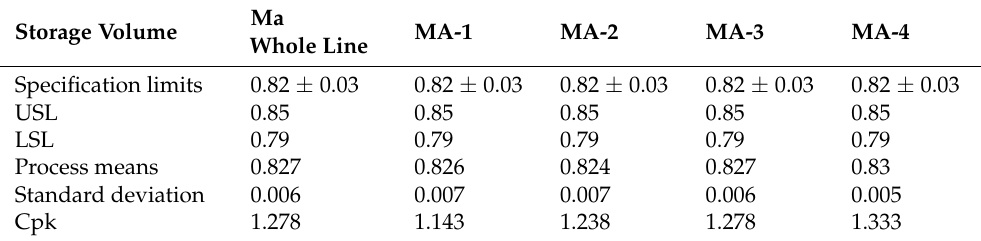
Table 3. The performance of initial state of the